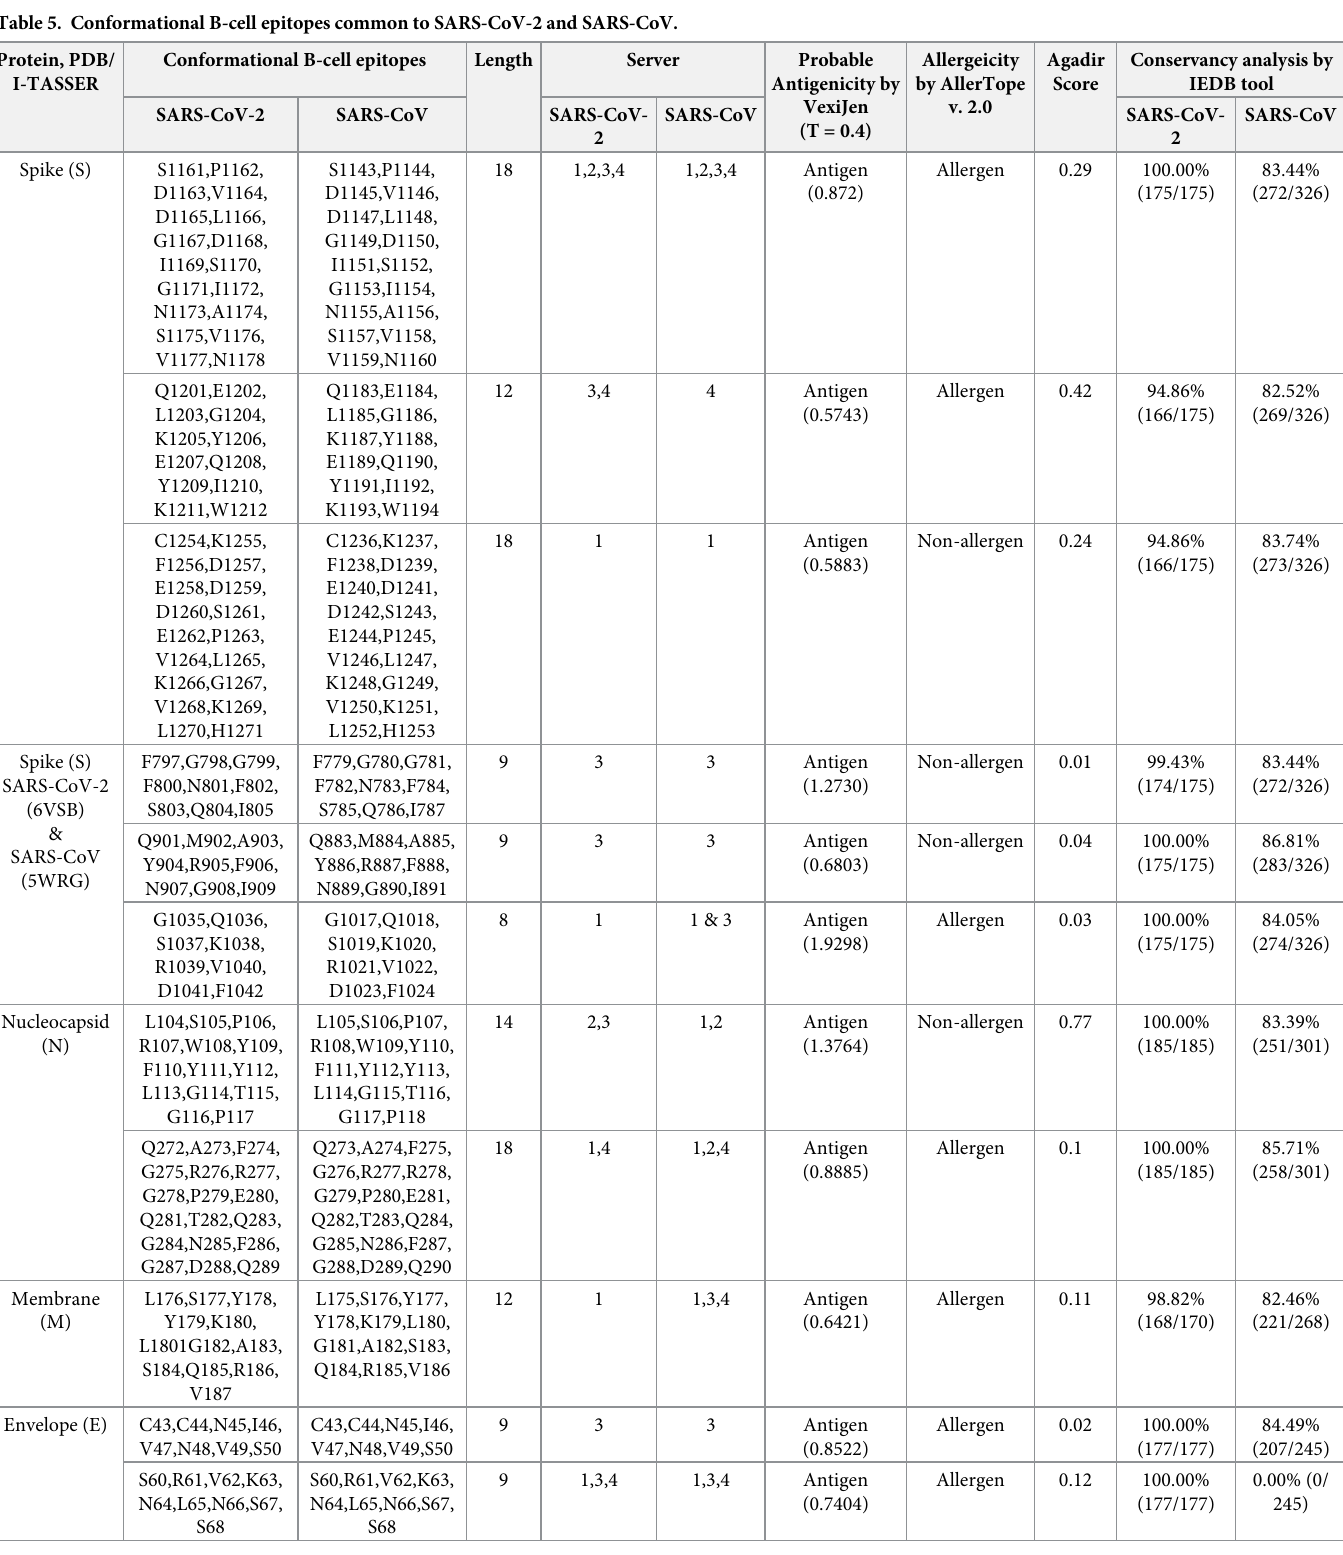
Table 5. Conformational B-cell epitopes common to SARS-CoV-2 and SARS-CoV. Protein, PDB/